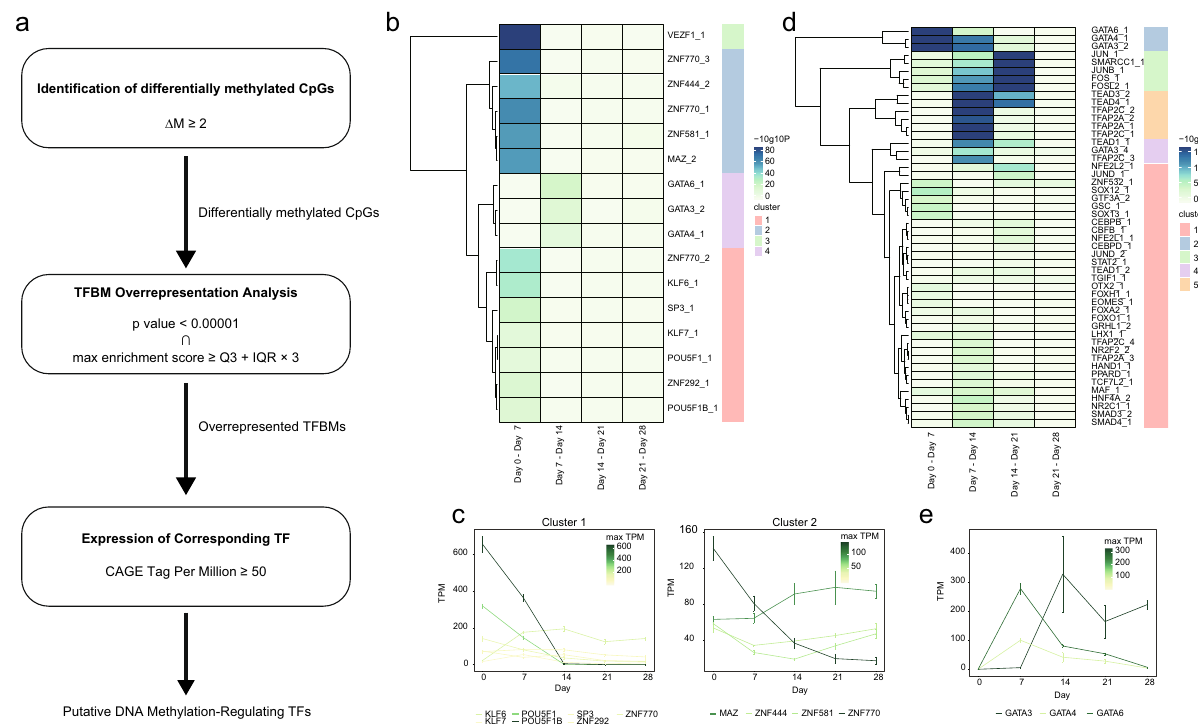
Fig. 2 Prediction of DNA methylation-regulating TFs. a The work fl ow of DNA methylation-regulating TF prediction. b , d Heatmap showing the P value of the one-sided (greater) exact Poisson test of overrepresented TF binding motifs at methylated ( b ) and demethylated ( d ) regions. Each column is an interval of adjacent time points. Each row is a putative methylation-regulating TF. The dendrogram of hierarchical clustering is shown at the left of the heatmap, and clusters are shown at the right of the heatmap as colors. c mRNA expression pro fi le of the cluster 1 and 2 putative DNA methylation- regulating TFs for methylated regions. X- and Y-axes show time points of differentiation (hours from differentiation initiation) and tag-per-million (TPM) of CAGE, respectively. The color of each line and the error bar represent the maximum TPM and s.d, respectively. The experiment was performed in three biological replicates. mRNA expression pro fi les of the clusters 3 and 4 putative DNA methylation-regulating TFs for methylated regions are shown in Supplementary Fig. 4. The experiment was performed in three biological replicates. e mRNA expression pro fi le of the GATA3, GATA4, and GATA6. X- and Y-axes show time points of differentiation (hours from differentiation initiation) and tag-per-million (TPM) of CAGE, respectively. The color of each line and the error bar represent the maximum TPM and s.d, respectively. The experiment was performed in three biological